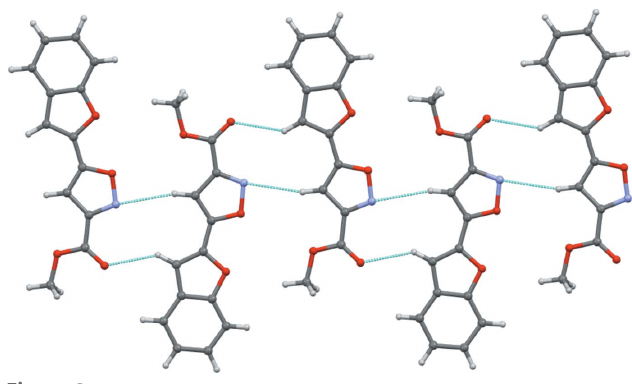
Figure 2 Intermolecular interactions forming a ribbon along the a